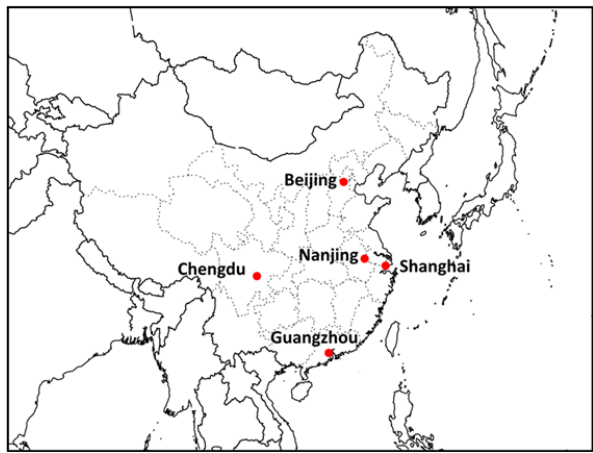
Figure 1. Location of major cities (Beijing, Nanjing, Shanghai, Chengdu and Guangzhou) mentioned in this